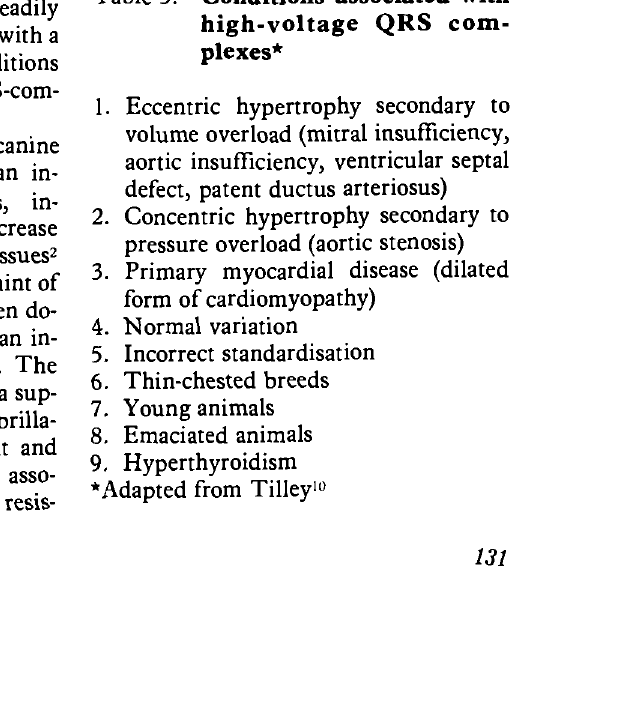
Table 3: Conditions associated